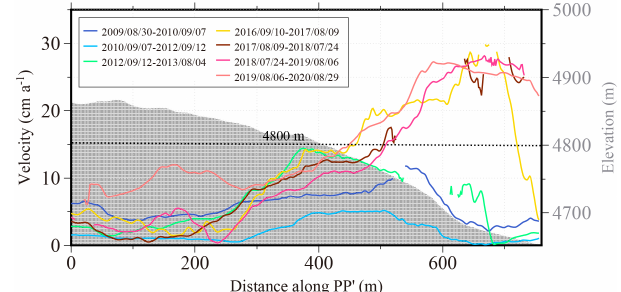
Figure 9. Surface velocities along the glacier central flow line PP (cid:48) (see Fig. 8a) during the seven image correlation periods. The light- gray-shaded area indicates the surface topography (right axis) along the